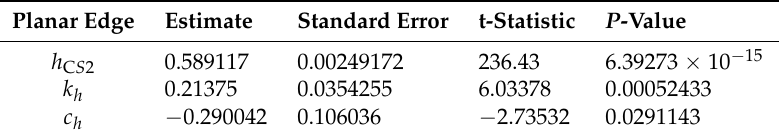
Table 6. The parameters of fitting h S 2 = h C S 2 + k h the vortex edge is lower than the vacuum value, compare to Table 3. The positive value of k h and the non-vanishing value of c h indicate a strong fluctuation of the color vector in short range when trespassing the vortex surface.